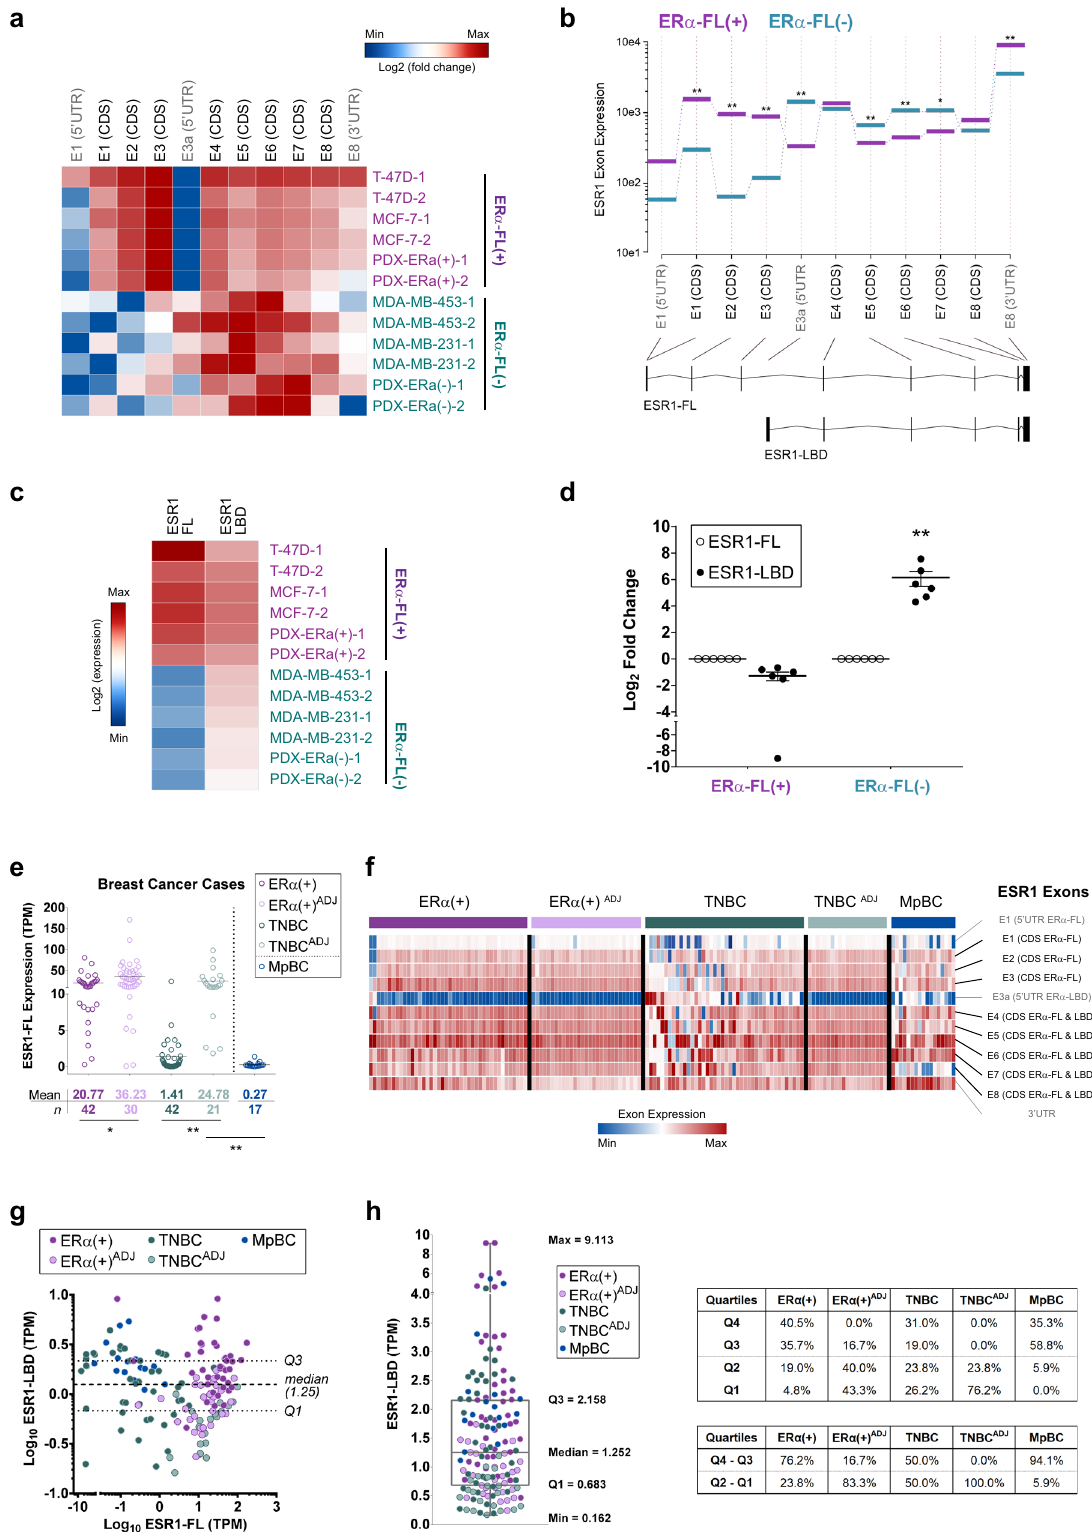
location. Using ER α immunohistochemistry (IHC), full-length expressing MCF-7 cells show robust nuclear staining that is markedly reduced 24 h after fulvestrant treatment. By contrast, ER α -LBD expressing models MCF-7 FulvRes, MDA-MB-453/-231,